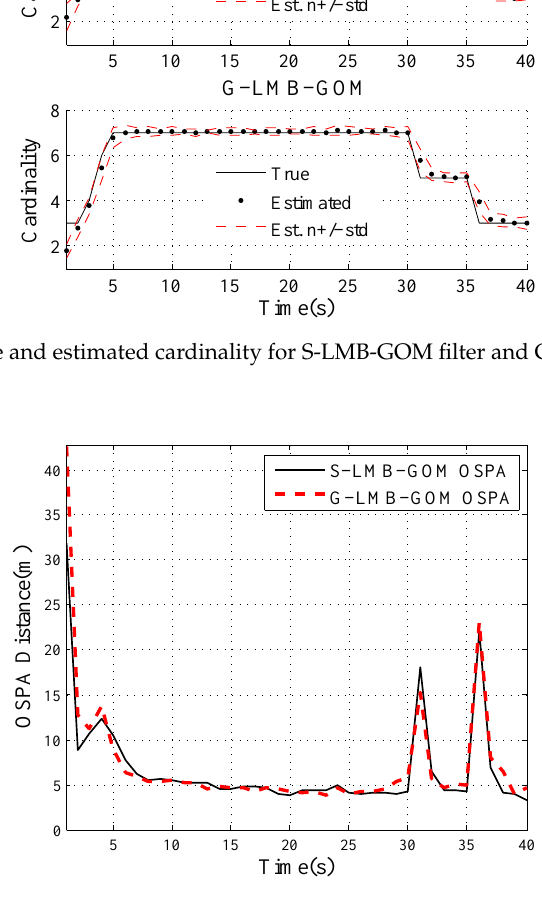
Figure 10. The OSPA distances for S-LMB-GOM filter and G-LMB-GOM filter.